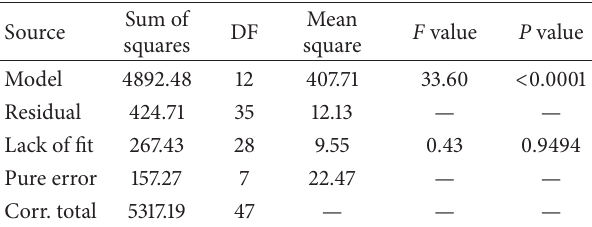
Table 5: ANOVA for the quadratic model developed for synthesis of TEA-based